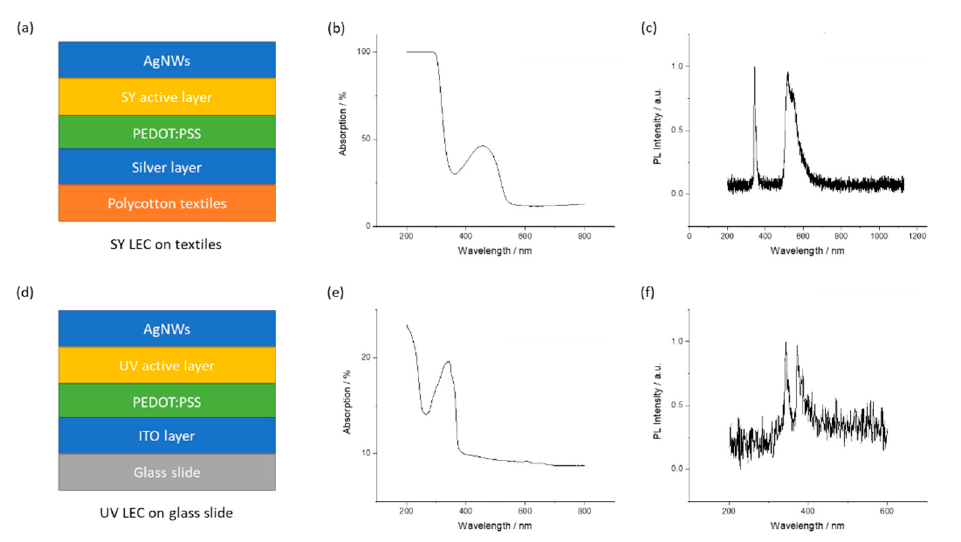
Figure 1. ( a ) Device architecture of SY (superyellow) OLEC, and ( d ) device architecture of UV OLEC, ( b ) absorption plots of the spray coated SY film on a glass slide, and ( e ) spray coated UV emitting molecule on a glass slide, ( c ) PL spectra of spray coated SY film on a glass slide, and ( f ) spray coated UV emitting film on a glass